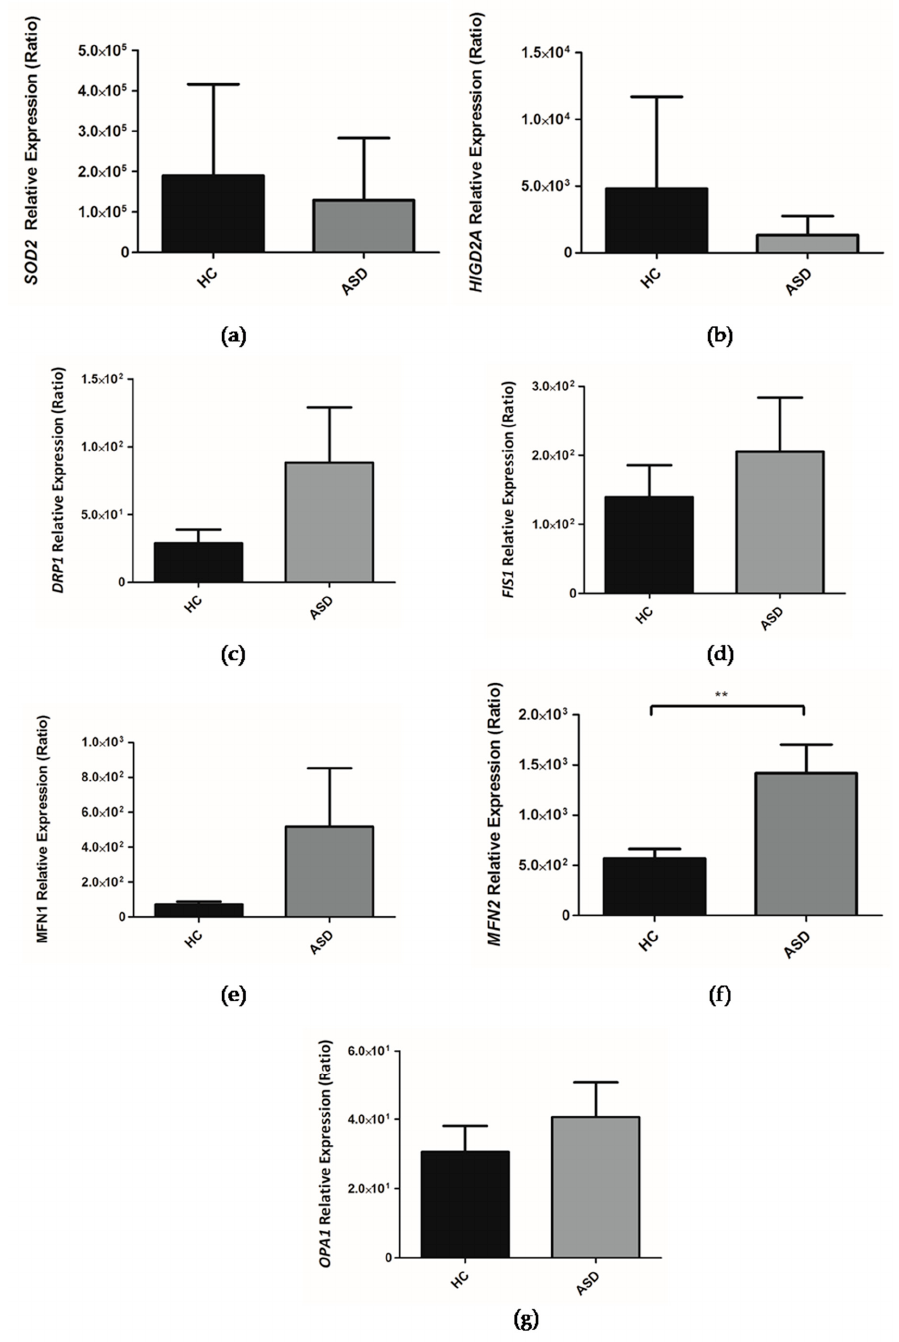
Figure 5. Relative expression of genes in children with Autism Spectrum Disorder (ASD) and Healthy Controls (HC). ( a ) SOD2 , ( b ) HIGD2A , ( c ) DRP1 , ( d ) FIS1 , ( e ) MFN1 , ( f ) MFN2 , ( g ) OPA1 . The PPIA gene was taken as a reference during the qPCR procedure. Each bar graph represents the mean ± SEM, n = 10 ASD and 11 HC children, analyzed by unpaired t-test (** P <